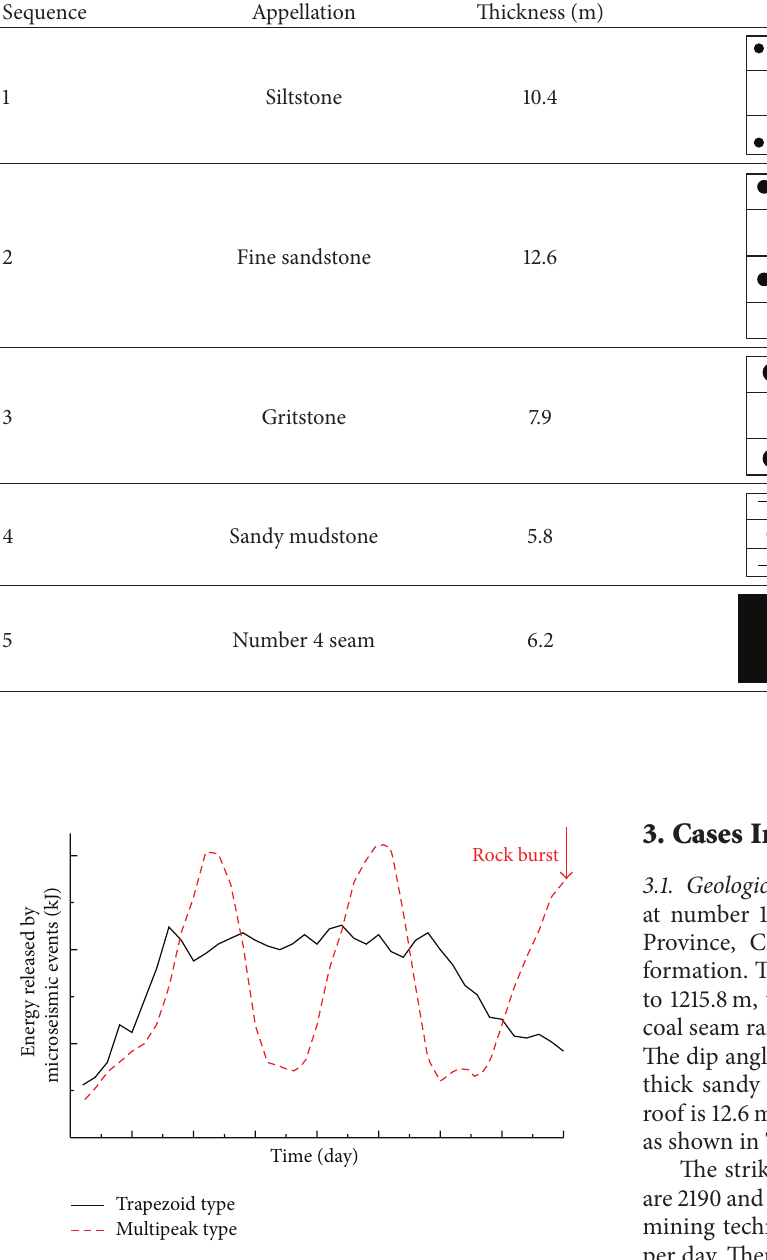
Figure 5: Patterns of the energy released by microseismic events with the closing of the coal face to the